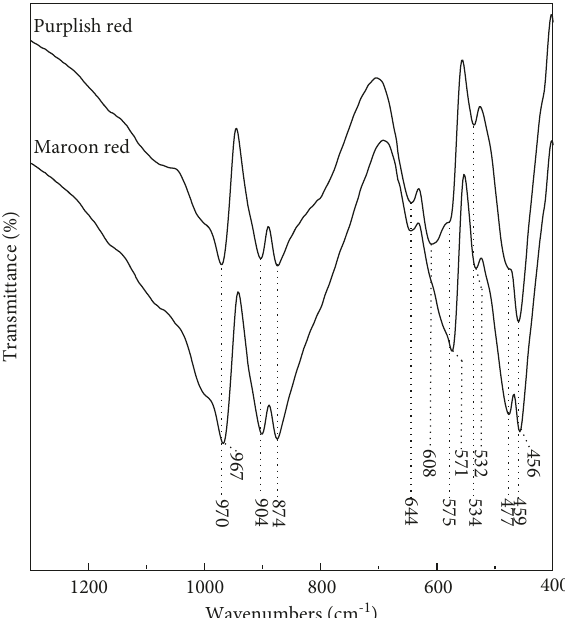
Figure 3: Fourier-transform infrared spectrum of the garnet samples. Table 1: Characteristics and attributes of the infrared absorption peaks of the purplish-red and maroon-red garnets. Absorption peaks of the garnet samples (cm − 1 ) Attributions of the absorption peaks Absorption peaks of the pyrope end-member [24] Purplish-red